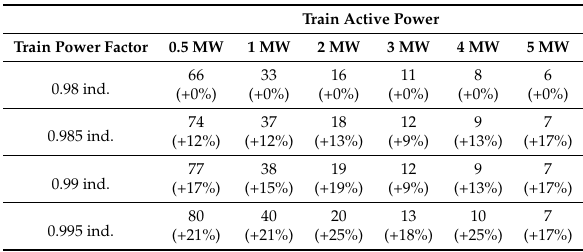
Table 3. Maximum number of trains, for different train power consumptions and for different power factor limit. Note: the percentage improvement from baseline (train PF = 0.98 ind.) is presented in parentheses. As an example, the baseline for P T = 2 MW is 16 trains; then for PF = 0.92 cap., it is possible to have eight more trains (+50% more than